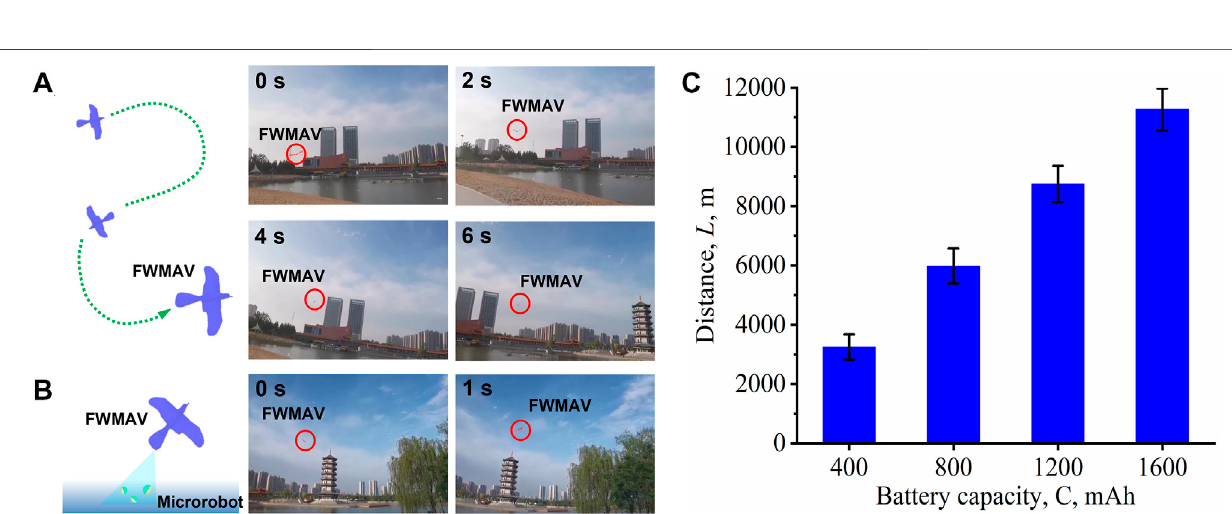
Frontiers in Bioengineering and Biotechnology | www.frontiersin.org June 2022 | Volume 10 | Article 903219